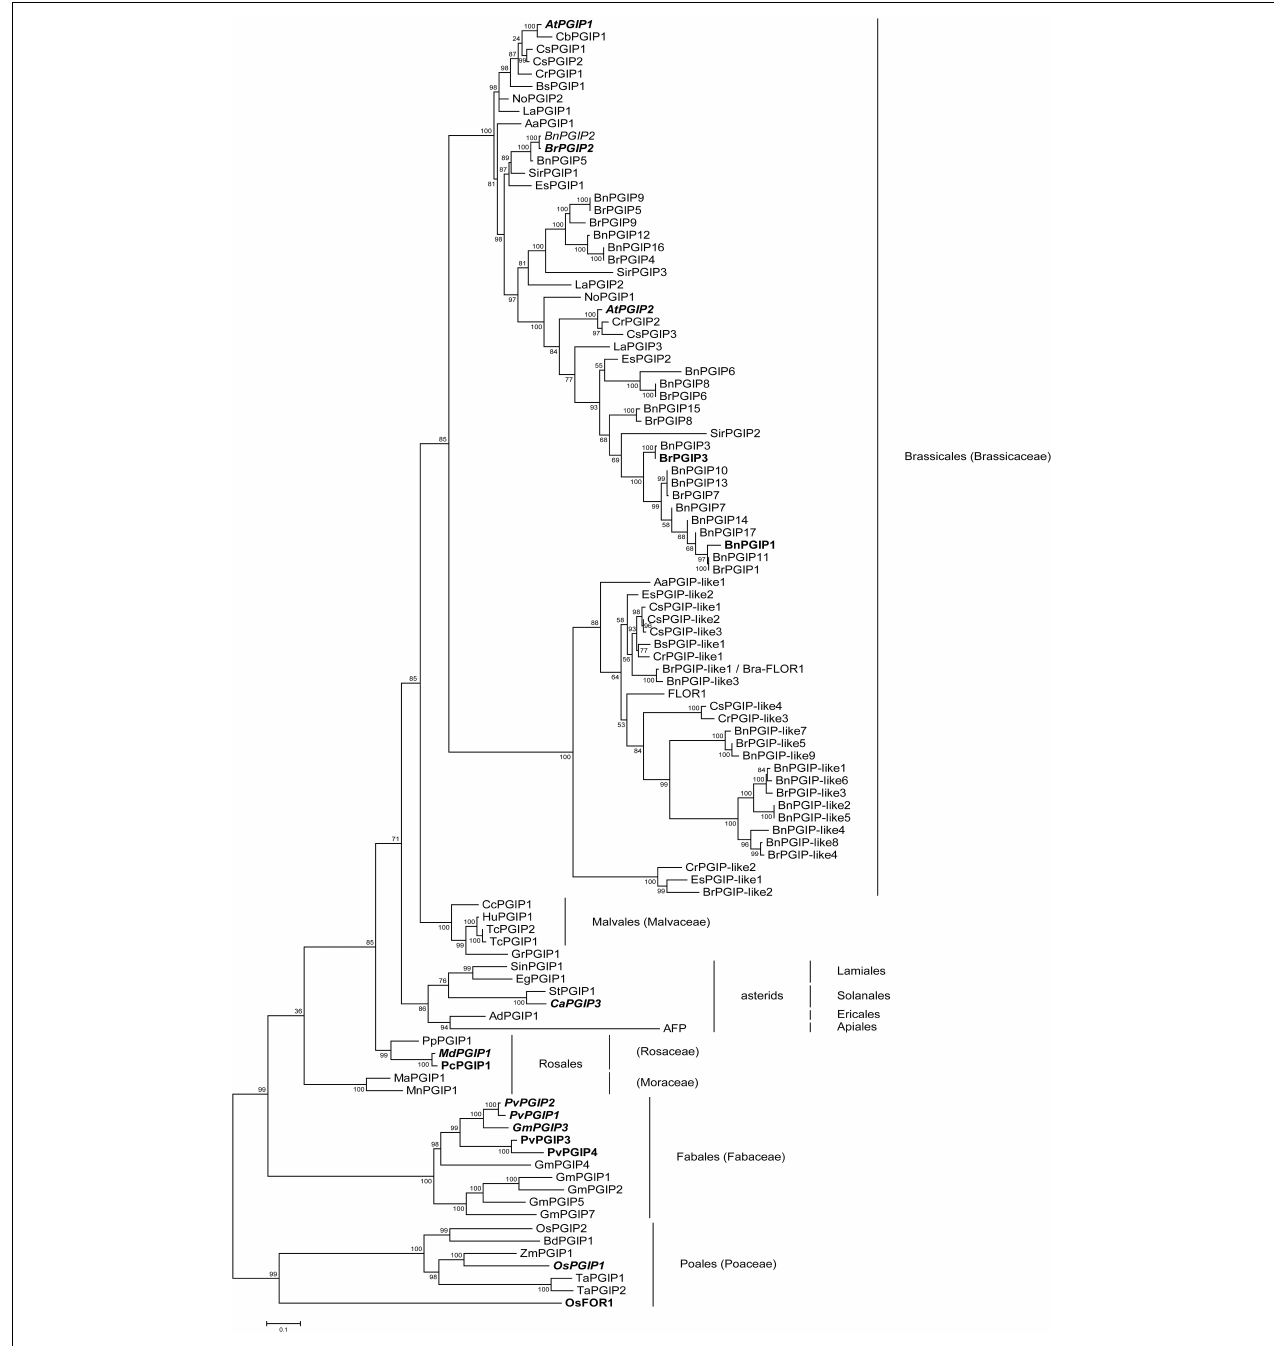
FIGURE 2 | Phylogenetic relationships of various PGIPs and PGIP-like proteins. A full list of abbreviations and sequences used from GenBank and other sources can be found in Supplementary Table 3 . PGIPs from Poales were used as an outgroup. Ultrabootstrap values are displayed for each node. Proteins printed in bold have been previously expressed in plants or heterologous systems and were tested positively for their inhibitory activity against microbial or insect PGs. Proteins with italicized names were overexpressed in planta and helped transgenic crops resist phytopathogenic fungi, oomycetes or